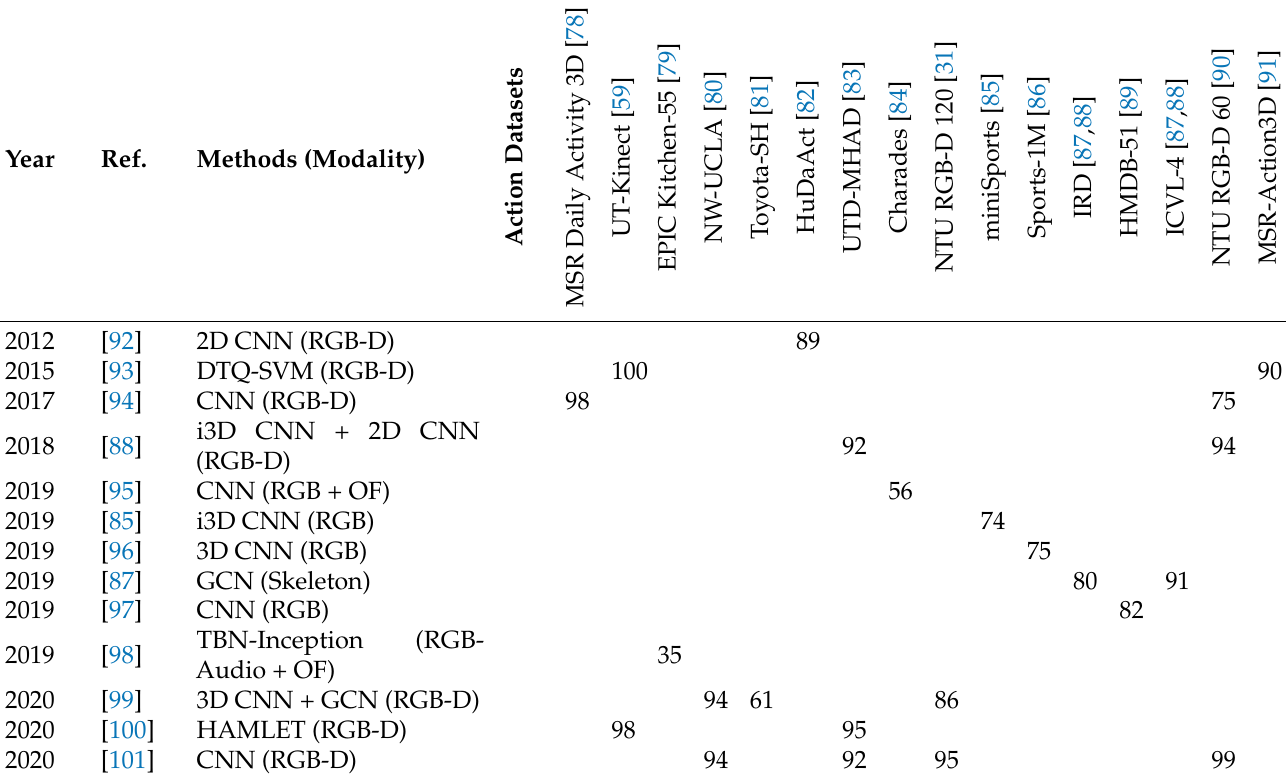
Table 2. Summary of popular action recognition datasets and methods that achieved the best recognition accuracy. Note that PDF stands for probability distribution function, i3D stands for inflated 3D, OF stands for Optical Flow, and GCN stands for Graph Convolutional Networks.